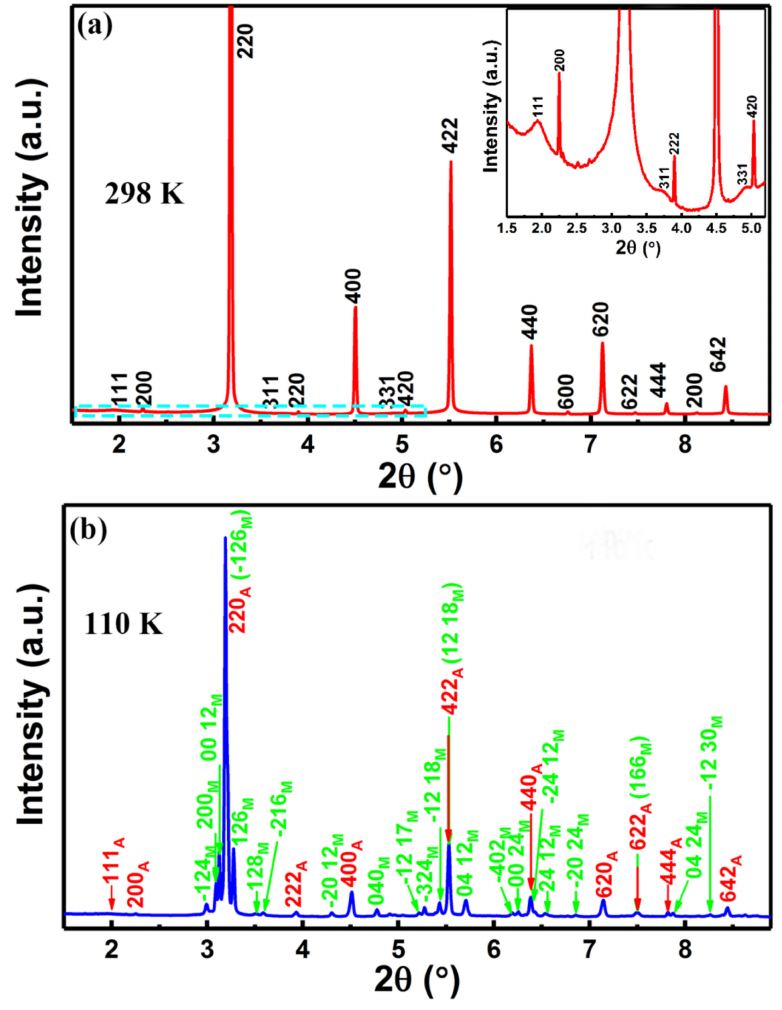
Figure 2. High-energy X-ray diffraction (HEXRD) patterns recorded at the temperatures of ( a ) 298 K and ( b ) 110 K for the Ni 50 Mn 34 Fe 3 In 13 microwire. The inset in ( a ) displays the magnified view of the pattern in the 2 θ range of 1.5–5.5 ◦ . “A” and “M” in the indices in ( b ) denote austenite and martensite,